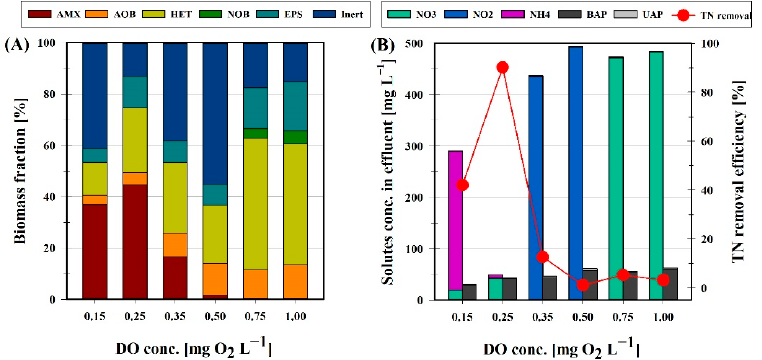
Figure 6. Biomass fractions ( A ) and nitrogen removal ( B ) at different dissolved oxygen concentration level. Simulation results for 0.5 mm of granule diameter, 500 mg N L − 1 of influent ammonium.